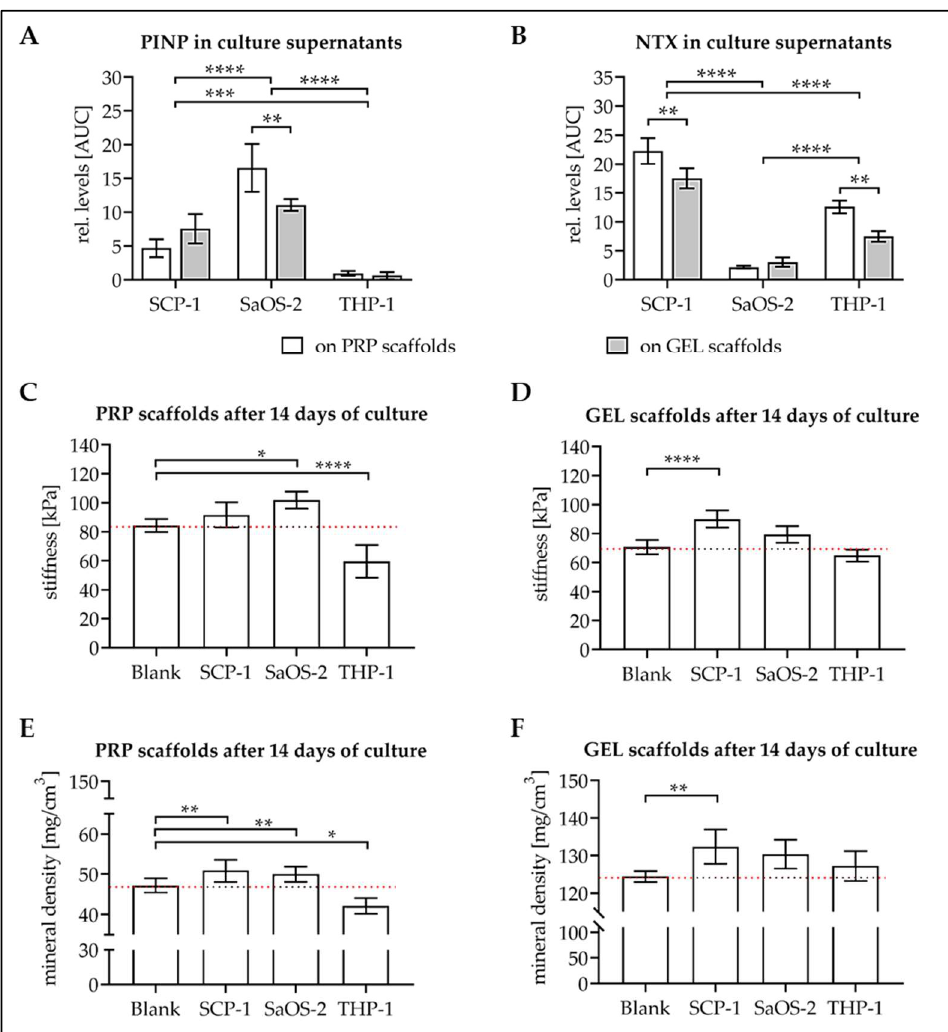
Figure 6. Changes in scaffold matrix after 14 days of culture with the different cell types. Twenty thousand SCP-1 cells, 4 × 10 4 SaOS-2 cells, and 8 × 10 4 THP-1 cells were seeded on each scaffold and differentiated. On days 4, 7, and 14, conditioned medium (72 h) was collected. Dot blot analysis was performed to determine relative levels of ( A ) PINP = procollagen type I N-terminal propeptide and ( B ) NTX = collagen-type I N-telopeptide. AUC = area under the curve, summarizing the 14 d of differentiation. On day 14 ( C , D ) stiffness and ( E , F ) mineral content of ( C , E ) PRP scaffolds and ( D , F ) GEL scaffolds were determined. Each experiment was performed three times (N = 3), at least, in triplicates (N ≥ 3). Two-way ANOVA or non-parametric Friedman test was used for data comparison between groups. * p < 0.05, ** p < 0.01, *** p < 0.001, and **** p < 0.0001 as indicated.